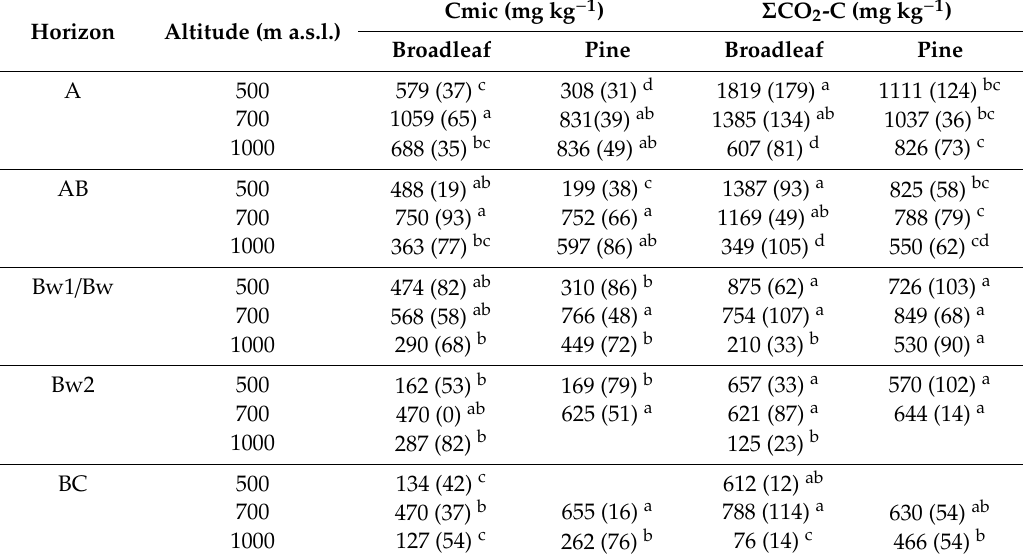
Table 3. Content of microbial biomass carbon (Cmic) and cumulative amount of CO 2 -C evolved during 21 days of incubation ( Σ CO 2 -C) of the soils under the broadleaf and pine forests at 500, 700